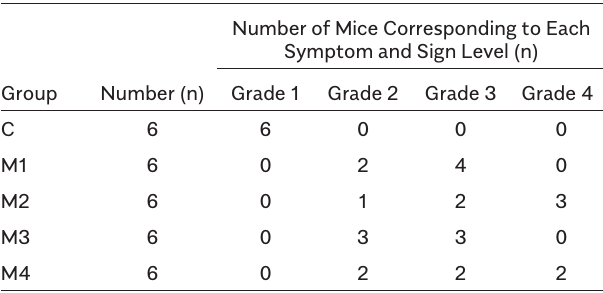
Table 1. Classification of Symptoms and Signs in Each Group